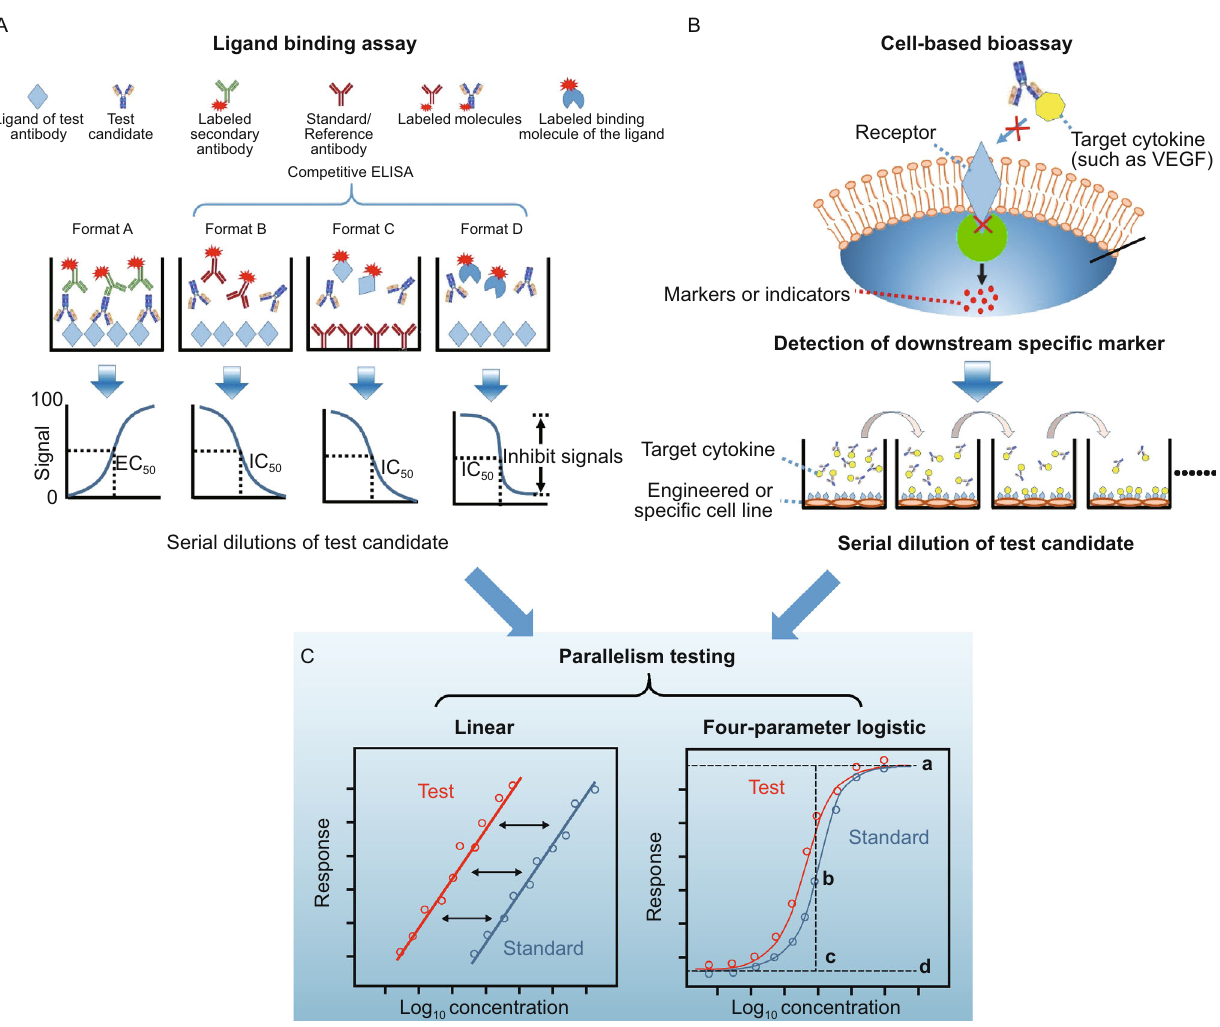
Figure 2. Schematic diagrams of ligand-binding assays and cell-based potency assay. (A) Four different types of ELISA-based ligand-binding assays (Biacore assays can be designed in a similar way). Format A is a direct way to evaluate the binding activity to the intended receptor. Formats B and C are both competitive ELISA; Format C is highly preferred for puri fi ed IgG since there are no subsequent wash cycles for the test antibody, unlike in the other three types. Format D is a ligand-blocking assay in the form of a competitive ELISA. (B) Cell based bioassay. The therapeutic mAbs are generally target cytokines or cell-surface receptors (In this diagram, the mAbs target cytokines as an example). Based on the understanding of the mechanism of action of mAbs, an